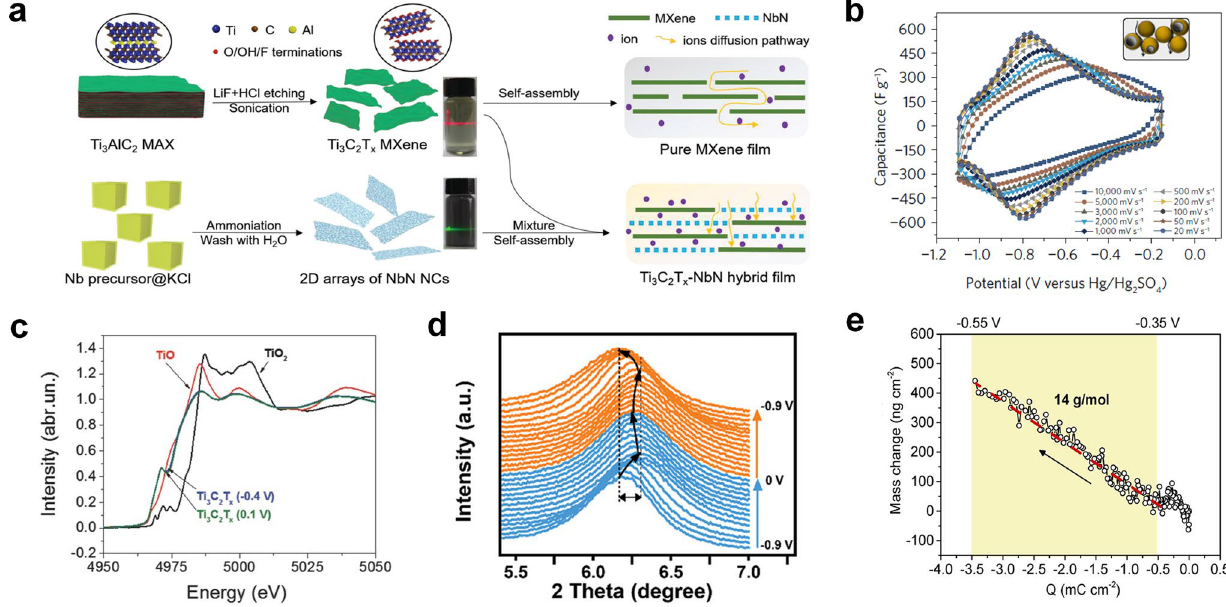
Fig. 6 a Diagram of structure and synthesis of MXene nanosheets [118]. Copyright 2020, Wiley–VCH. b Capacitance of macroporous Ti 3 C 2 T x electrode at various scan rates in 3 M H 2 SO 4 [27]. Copyright 2017, Springer Nature. c Ti K-edge XANES spectra of Ti 3 C 2 T x at − 0.4 and 0.1 V [83]. Copyright 2015, Wiley–VCH. d Electrochemical in situ X-ray diffraction study of Ti 3 C 2 T x in 1 M H 2 SO 4 [85]. Copyright 2019, Wiley– VCH. e MXene electrode mass and response charge changes in 3 M H 2 SO 4 [86]. Copyright 2020, American Chemical